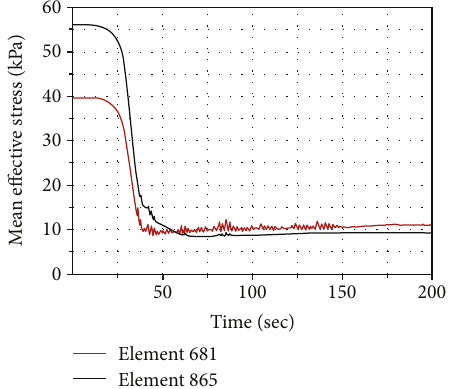
Figure 19: Time history of response horizontal acceleration for node 1201.